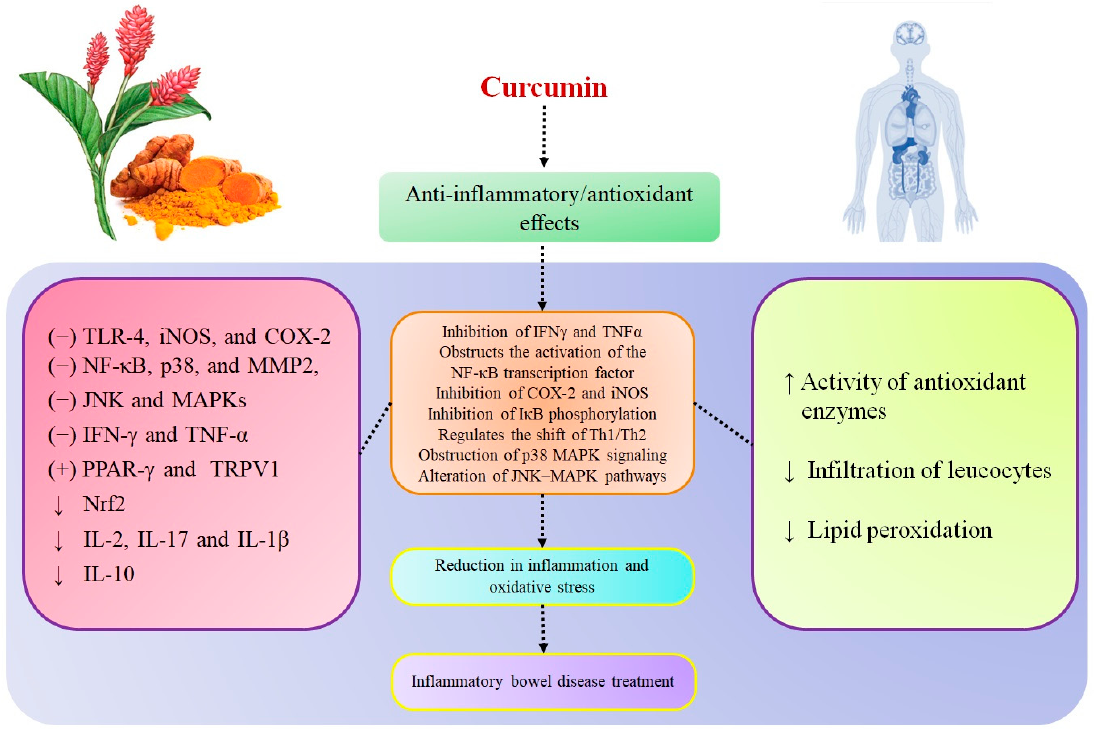
Figure 2. Curcumin’s potential and molecular targets in inflammatory bowel disease (IBD) treatment, adapted from [25,66–74].